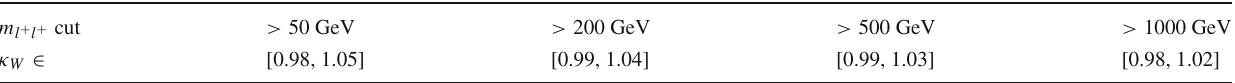
Table 4.5 Constraints on the HWW coupling modifier κ W at 68% CL, obtained for various cuts on the di-lepton pair invariant mass in the W L W L → HH